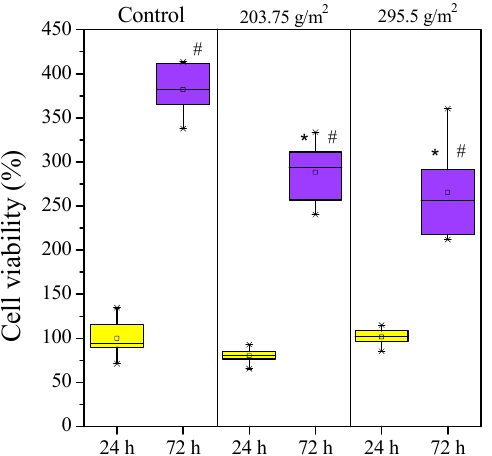
Figure 4. Box plot and statistical analysis of cell viability study of NHDF cells in the presence of SIBS/ZnO matrices. * p < 0.05 compared to the control at the same time point, # p < 0.05 compared to the previous time point in the same group.